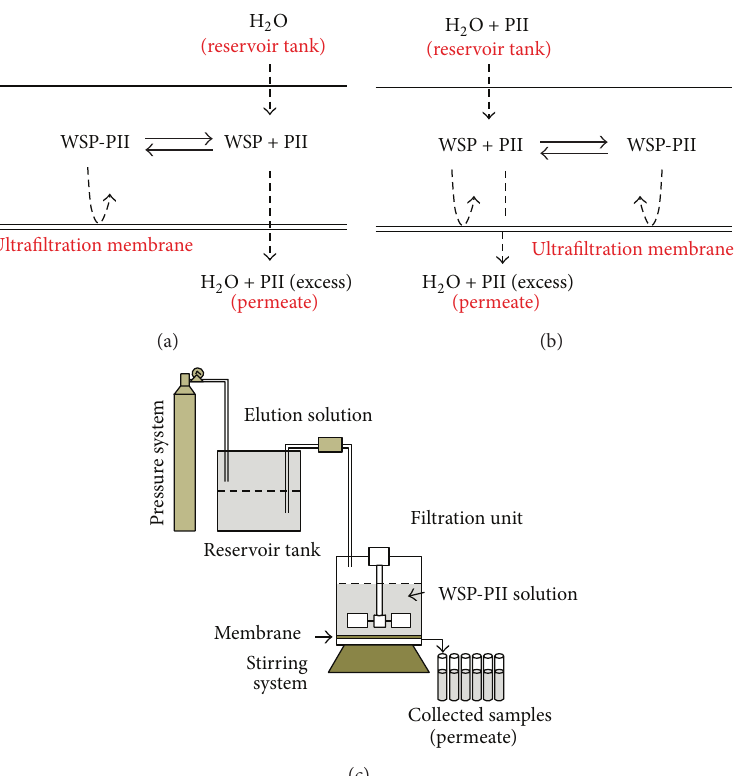
Figure 1: Description of LPR technique by washing method (a) and enrichment method (b) and schematic representation of experimental device